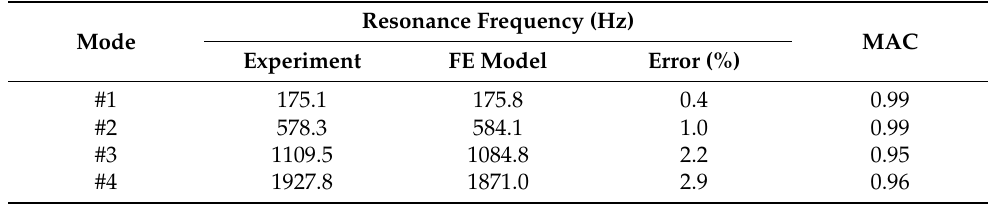
Table 2. Error analysis for SCS13A specimen.